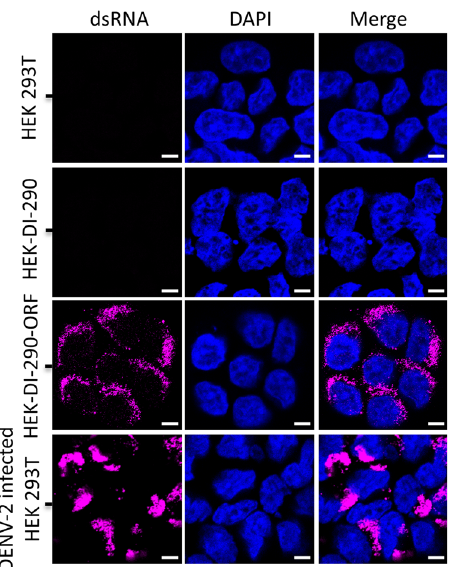
Fig. 2 DI-290 RNA replication in HEK-DI-290-ORF cells. Confocal fl uorescence microscopy of HEK 293T, HEK-DI-290, HEK-DI-290-ORF, and DENV-2 infected HEK 293T cells that were stained with an anti-double strand RNA antibody (magenta). The cells were counterstained with DAPI to stain nuclei (blue). The white bar in the image represents 10 µ